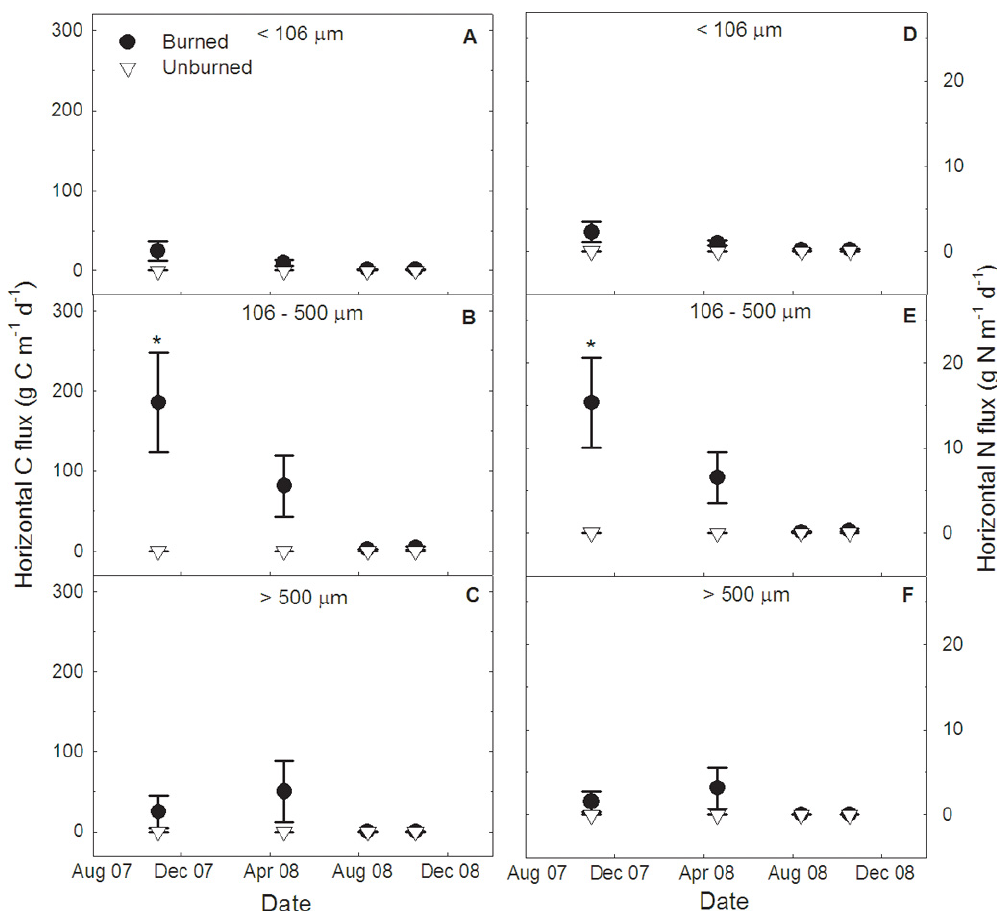
Fig. 4. Mean ( ± SE) horizontal fluxes of carbon (A) – (C) and nitrogen (D) – (F) among the different particle size classes of sediment in the burned (filled circles) and unburned (open triangles) area (* denotes significant site differences at P < 0 .